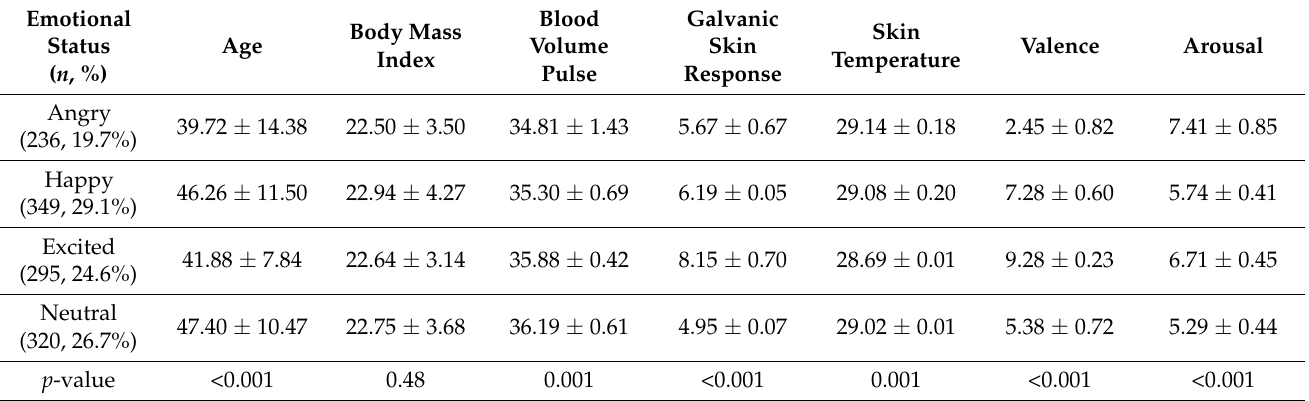
Table 2. Comparative analysis of variables in different emotional